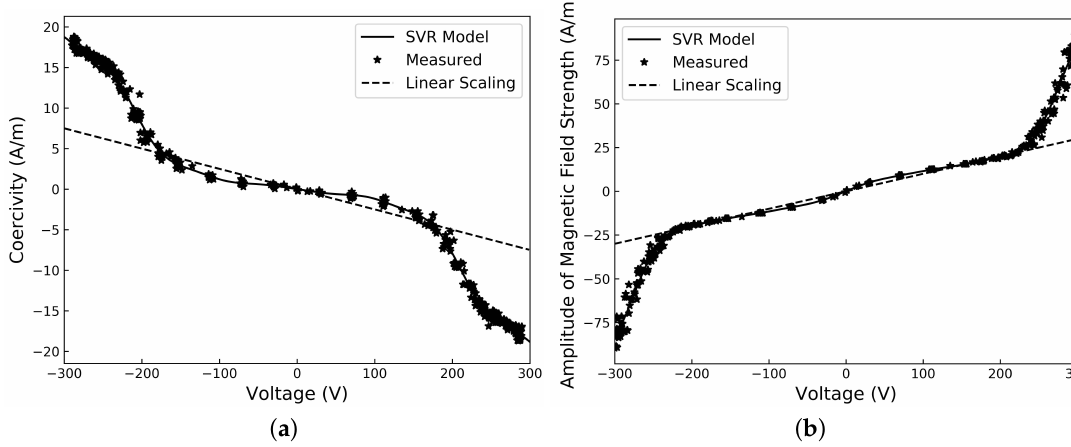
Figure 7. The SVR prediction of ( a ) H c and ( b ) H amp under different excitation voltages.